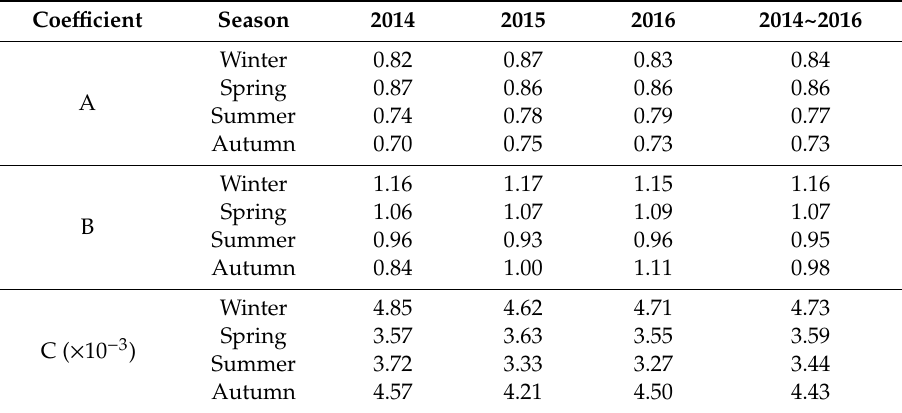
Table 4. Seasonal variations of the Gompertz model coe ffi cients by year.